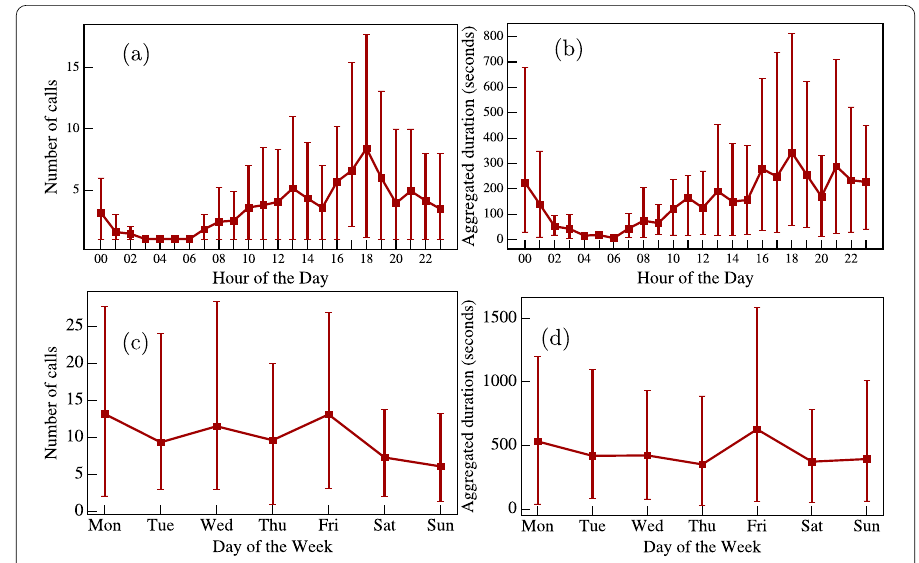
Figure 2 Timelines of communication events. ( a ) Number of calls between participants on an hourly basis throughout the day. ( b ) Aggregated duration of calls on an hourly basis throughout the day. ( c ) Number of calls on a daily basis throughout the week. ( d ) Aggregated duration of calls on a daily basis throughout the week. Each data point is normalized by the number of individuals present at that time and the error bars go from the 10th to the 90th percentile of the distribution of values over different individuals and different days or